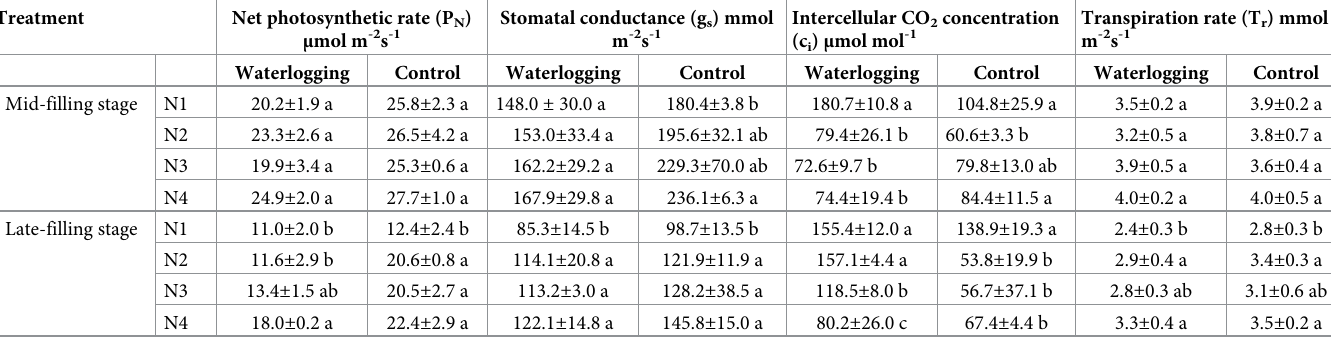
Table 3. Effects of different N regimes on the photosynthetic capacity of summer maize subjected to waterlogging stress at the seedling stage (2015).